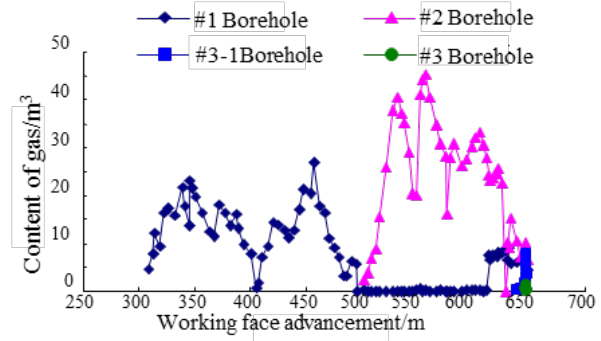
Figure 13. Relationship between the gas extraction amount and the mining distance in the gas drainage borehole.